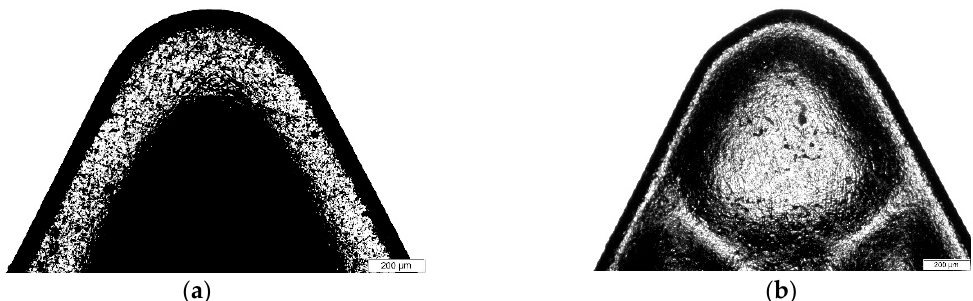
Figure 3. Optical microscope images of edge geometry: ( a ) conventional insert ( b ) wiper insert [7].